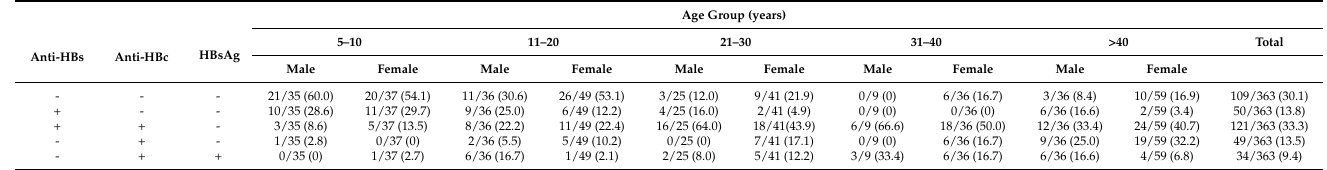
Table 2. Hepatitis B virus serology by age group and sex. Anti-HBc positive/anti-HBs negative samples were screened for HBsAg. All other samples were assumed to be HBsAg negative [4].